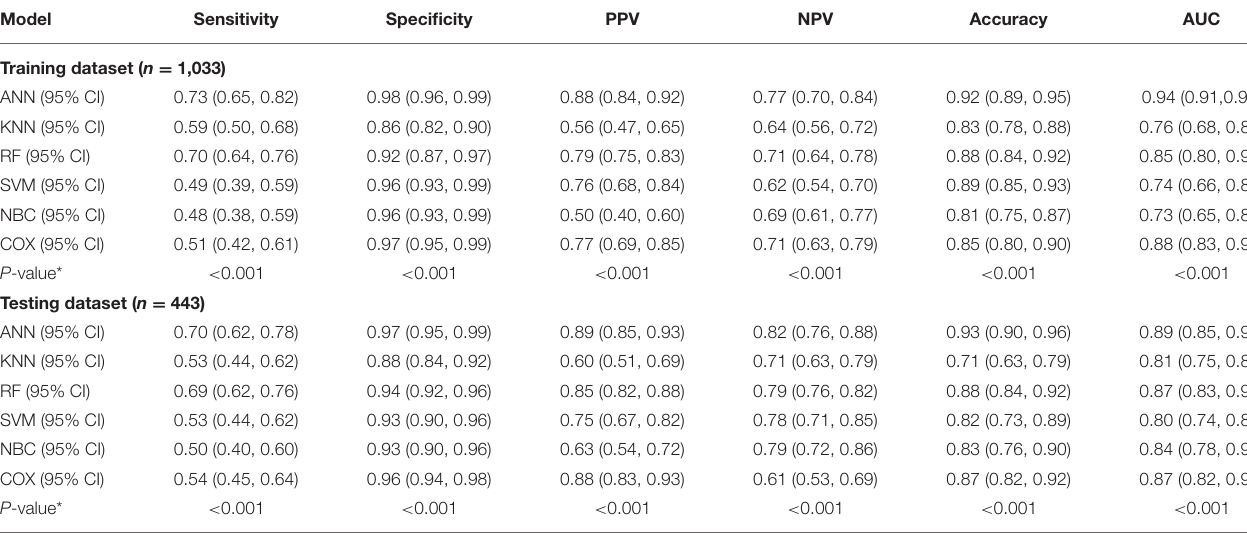
TABLE 5 | Comparison of 1,000 pairs of forecasting models for predicting 30-day readmission in patients with stroke ( N = 1,476).